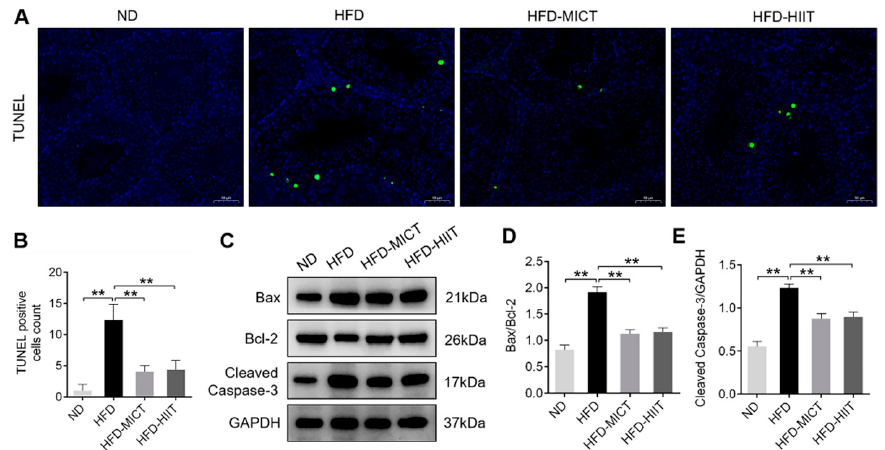
Figure 6. Effects of MICT and HIIT on testicular apoptosis in obese mice. ( A ) TUNEL staining and ( B ) quantitative analysis of mouse testes. The positive apoptotic particles are in green and the nuclei are in blue. ( C – E ) Protein levels of of Bax, Bcl-2 and Cleaved Caspase-3 were detected by Western blot. Data are expressed as mean ± SEM. ** p <